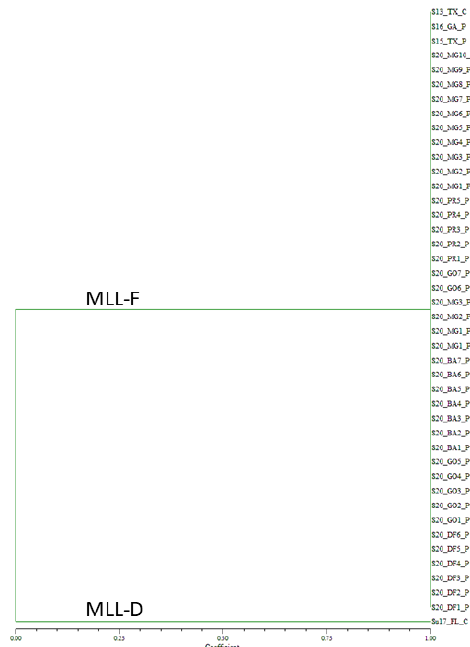
Figure 3. Unweighted pair group method with arithmetic mean dendrogram of 2020 Melanaphis spp. Samples collected on sorghum from ten Brazilian cities. Samples were genotyped using eight simple sequence repeat markers. All the samples collected in Brazil in 2020 were found to be MLL-F ( Melanaphis sorghi ). MLL, multilocus